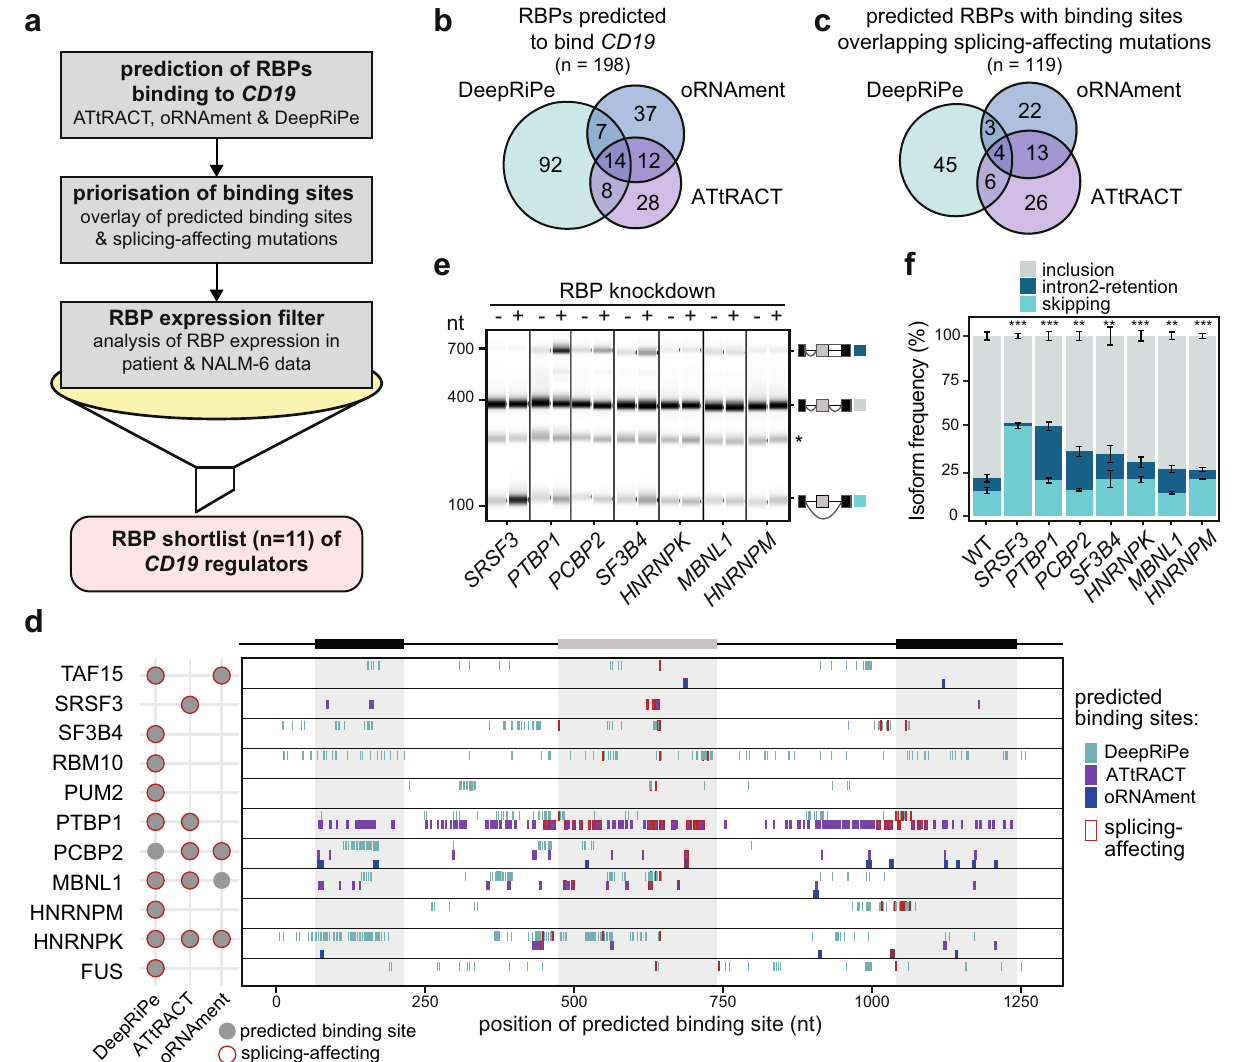
Fig. 5 In silico predictions identify RBP regulators of CD19 alternative splicing. a Pipeline for the identi fi cation of potential RBP regulators of CD19 splicing. Starting with in silico predictions, we obtained 198 candidate RBPs with predicted binding motifs (ATtRACT/oRNAment) or predicted differential binding upon mutation (DeepRiPe). These were prioritised by overlapping with the splicing-affecting mutations from our screen. Additionally, based on publicly available RNA-seq data, we required a minimum mean expression in RNA-seq data from B-ALL patients 31 and NALM-6 cells 75 . Together with literature information, we shortlisted 11 candidate RBPs for knockdown (KD) experiments, including SRSF3 as a positive control. b , c In silico analyses predict dozens of RBPs binding to CD19 . Venn diagrams show overlap of RBPs in initial predictions ( b ) and after overlay with splicing-affecting mutations ( c ). d The 11 candidate RBPs are predicted to bind throughout the CD19 minigene region. For each RBP, the binding sites predicted by ATtRACT and oRNAment and disrupting mutations predicted by DeepRiPe are indicated (see legend). Sites overlapping with splicing-affecting mutations are framed in red. The schematic summary (left) shows that all 11 candidate RBPs have at least one predicted site that overlaps with a splicing-affecting mutation. A full list of predicted binding sites (ATtRACT/oRNAment) and differential binding mutations (DeepRiPe) is provided in Supplementary Data 6. e , f Seven RBP KDs signi fi cantly change CD19 splicing. Gel-like representation ( e ) and quanti fi cation ( f ) of semiquantitative RT-PCR showing detected isoforms exon 2 inclusion (grey), intron 2 retention (blue), and skipping (turquoise) from the endogenous CD19 gene in KD and control NALM-6 cells. Asterisk indicates a previously reported RT-PCR artefact 66 (see methods). Error bars indicate s.d.m., n = 3 replicates. ** P value < 0.01, *** P value < 0.001, two-sided Student ’ s t test. Measurements for all 11 KD experiments are shown in Supplementary Fig. 8c, d. Source data including P values are provided as a Source Data fi